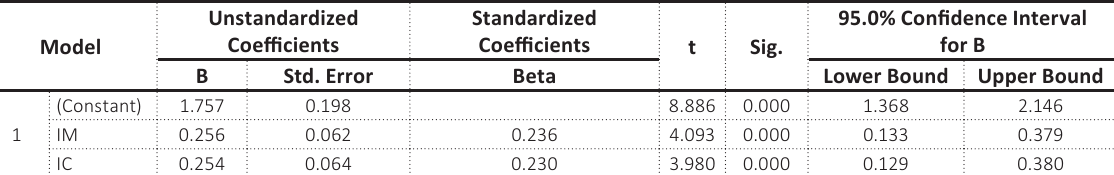
Table 6. Coefficients a for H